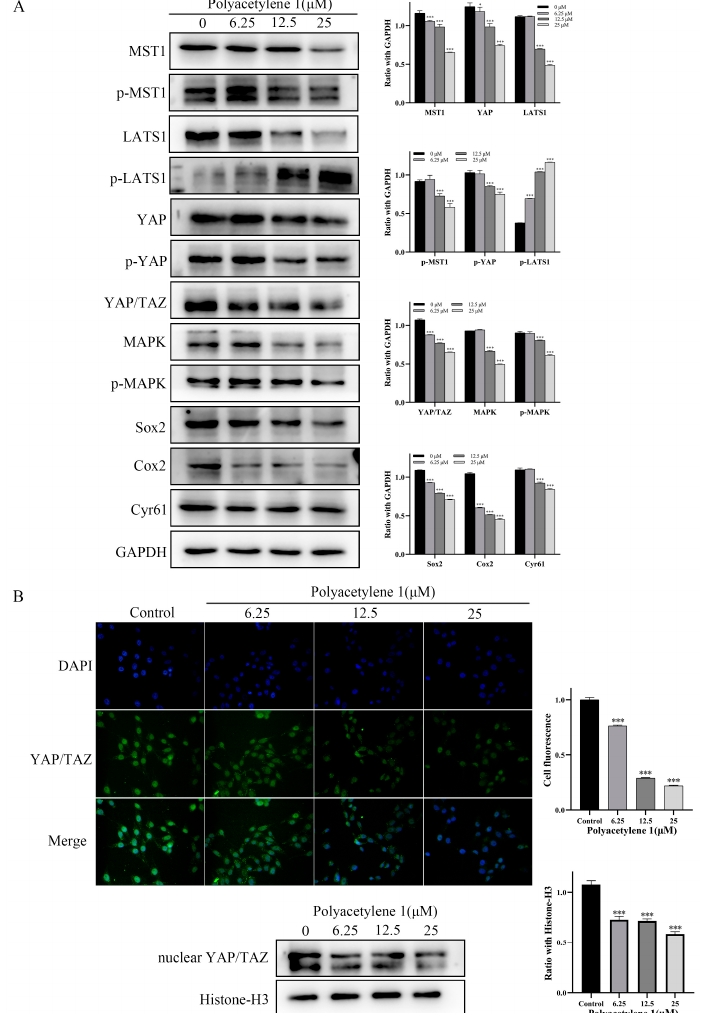
Figure 8. Effects of polyacetylene 1 on the Hippo/YAP signaling pathway in HGC-27 cells. ( A ) Western blot results of Hippo/YAP-signaling-pathway-related proteins in total lysates of HGC-27 cells treated with 25, 12.5, and 6.25 µM of polyacetylene 1 for 24 h. GAPDH was used to ensure an equal amount of loaded protein. ( B ) Immunofluorescence images and Western blot results of nuclear YAP/TAZ in HGC-27 cells treated with 25, 12.5, and 6.25 µM of polyacetylene 1 for 24 h. Nuclear counterstaining with DAPI is shown separately. Scale bars: 200 µm. Histone-H3 was used to ensure an equal amount of loaded protein. Significant differences compared with the control group are designated as * p < 0.05 and *** p < 0.001. Results are expressed as the mean ± SEM (n = 3).